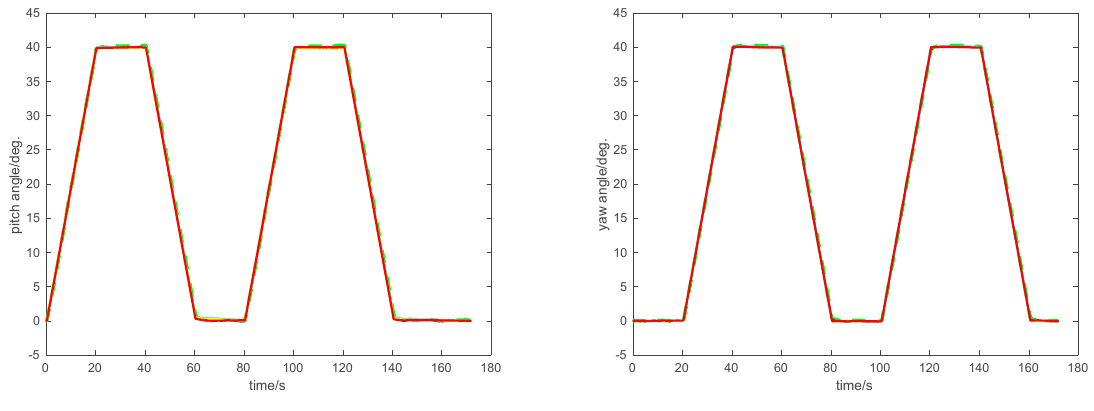
0.1376 Figure 10. Comparison of RMSE for different methods across three groups of experiments. Table 3. Running time of five methods. Running time/s